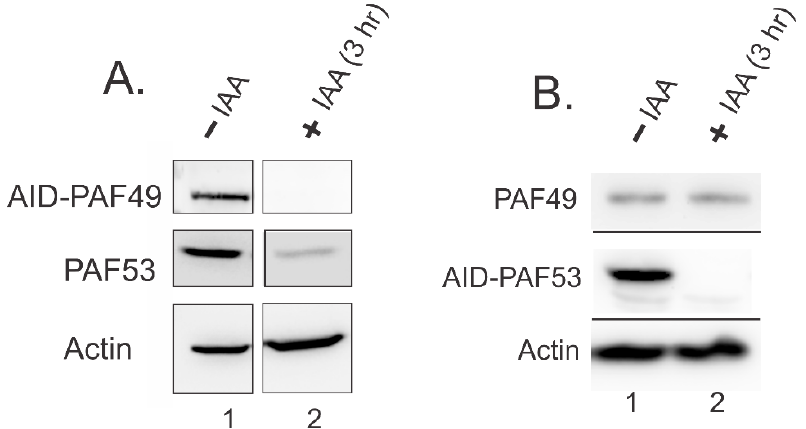
Figure 7. Targeted degradation of PAF49 results in the rapid depletion of PAF53 ( A ), but not vice versa ( B ). HEK293 cells expressing either AID-PAF49 or AID-PAF53 were treated with IAA for 3 h. After that, whole cell lysates were prepared, and the levels of PAF49 and PAF53 were investigated via Western blot analysis. ( A ) Lane 2 shows that upon targeted degradation of PAF49, the levels of PAF53 were depleted. ( B ) Lane 2 shows that targeted degradation of PAF53 did not cause the rapid depletion of PAF49.